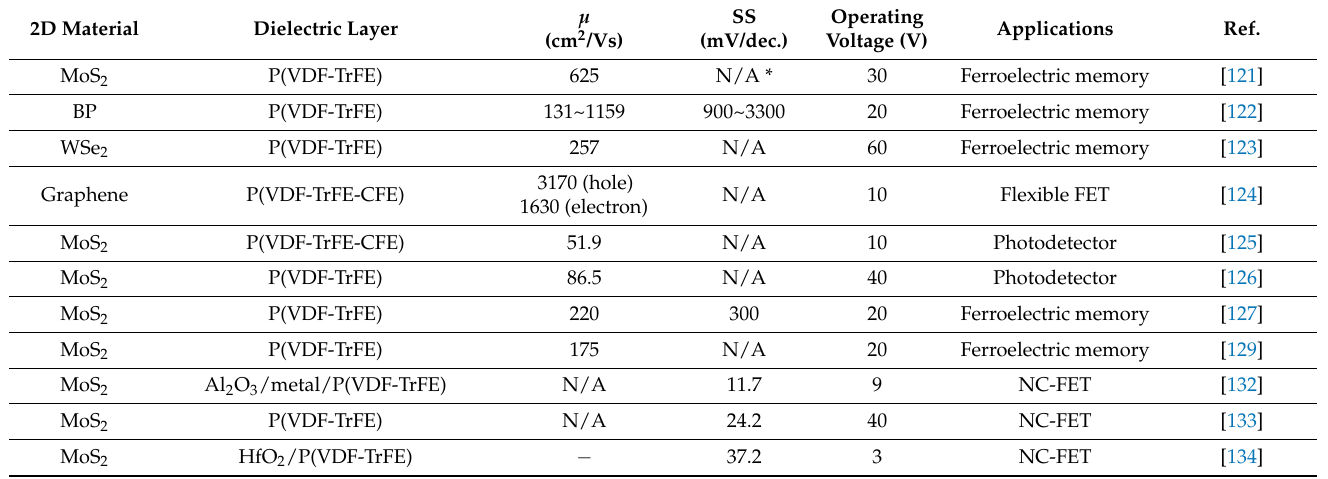
Table 2. Summary of materials and electrical characteristics of the 2D semiconductor FETs based on ferroelectric polymer gate dielectric